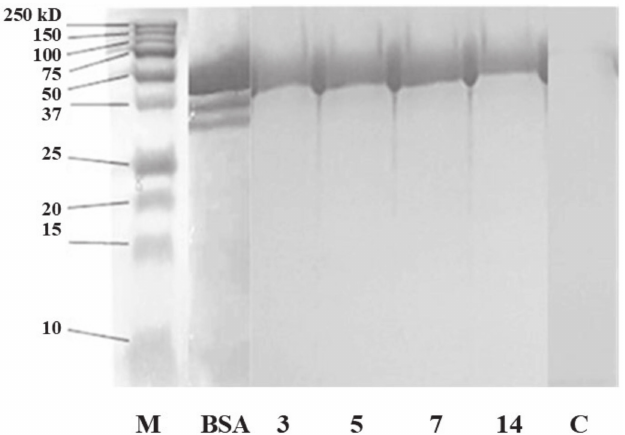
Figure 10. Sodium dodecyl polyacrylamide gel electrophoresis (SDS-PAGE) electrophoretic pattern of microsomes extracted from Eisenia fetida exposed to endosulfan lactone in solid substrate. M (molecular marker), BSA (bovine serum albumin), 3 (earthworms exposed for 3 days), 5 (earthworms exposed for 5 days), 7 (earthworms exposed for 7 days), 14 (earthworms exposed for 14 days), and C (control at 0 days